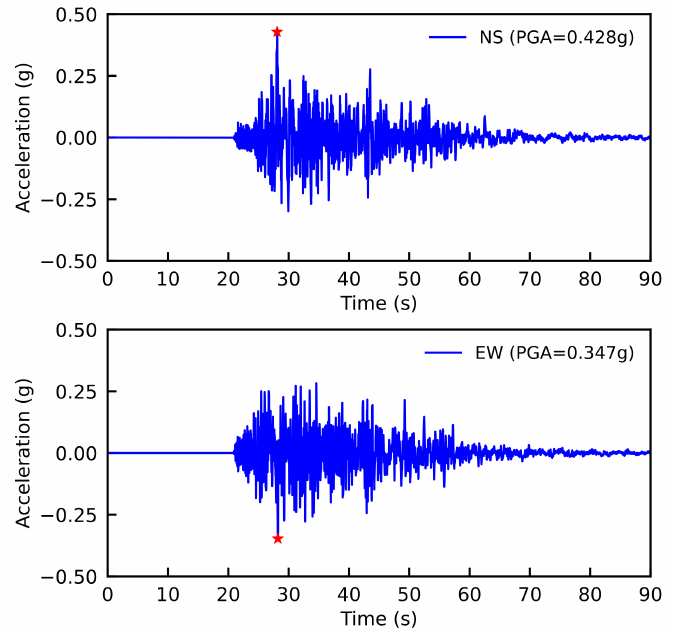
Figure 16. The 1999 Chi-Chi Earthquake acceleration histories recorded by TCU076 station.